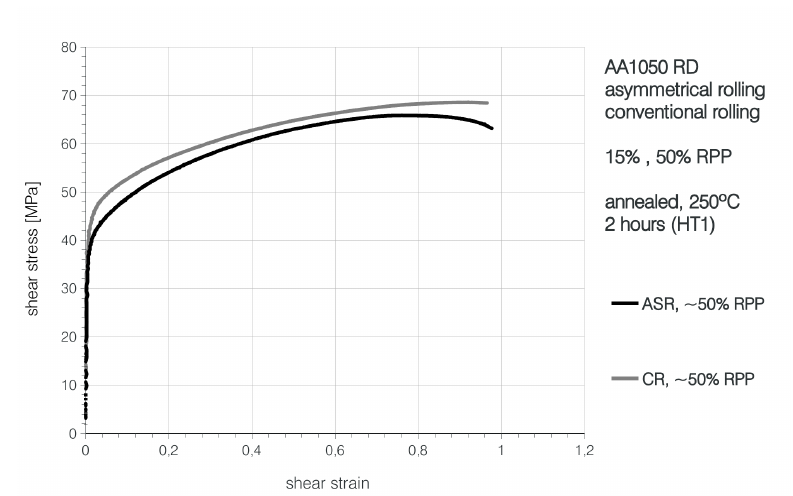
Figure 9. RD shear tests of rolled (50%RPP) and annealed (250 ◦ C for 2 h) specimens. Comparison between ASR and CR (adapted from [25] with permissions from authors,